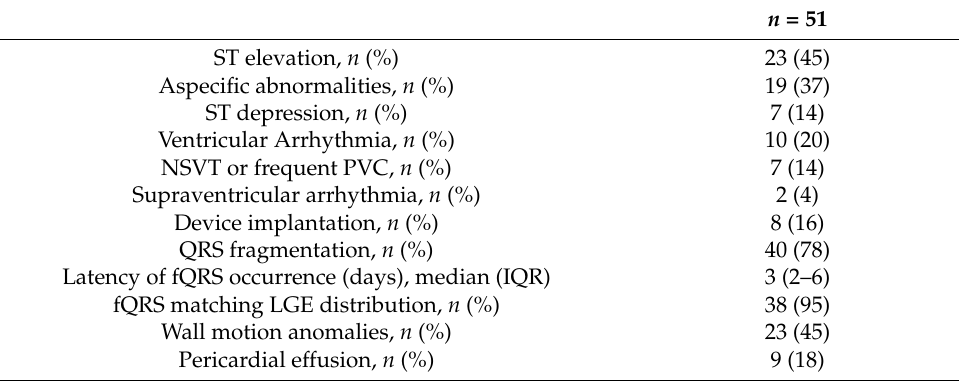
Table 3. ECG and rhythm disturbance in patients admitted with